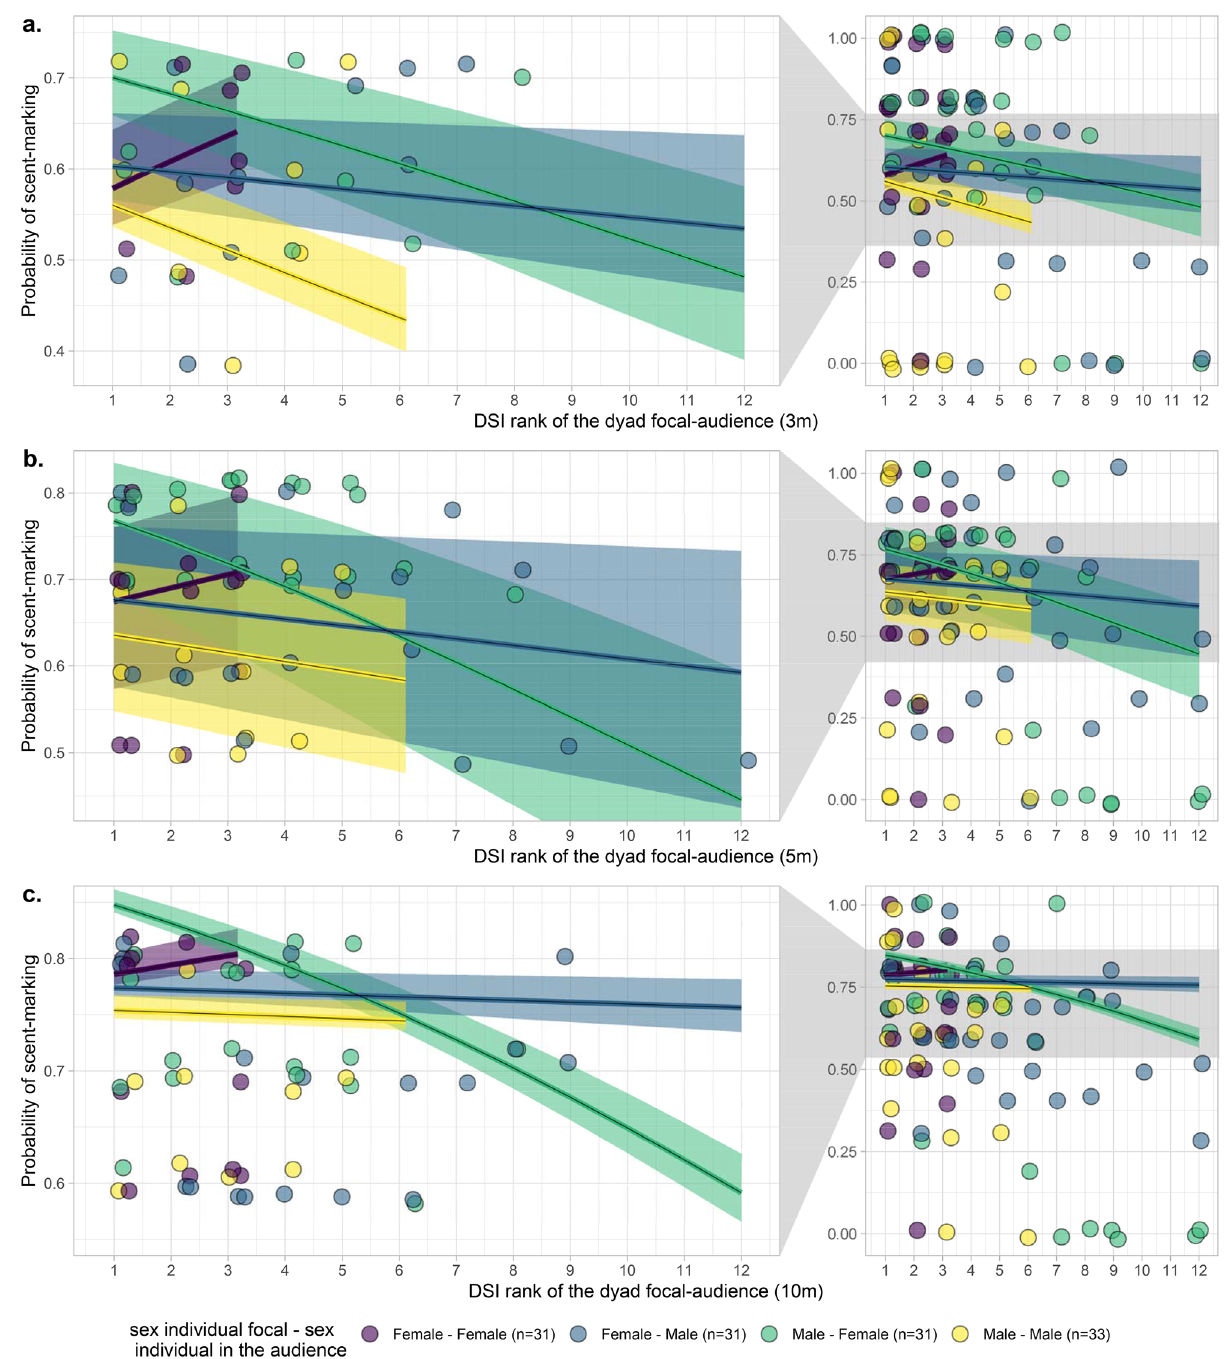
Figure 2. Probability to scent-mark as a function of the DSI rank of the dyad for an audience ( a ) in a 3 m radius,( b ) in a 5 m radius, and ( c ) in a 10 m radius. The shaded areas show 95% confidence intervals of the model (conditional on the number of observations being at its average and on a group effect weighted by the number of individuals in each group). The first column of plots presents the zoomed-in section of the full range, indicated by grey polygons, to better depict the corresponding regression lines. This figure was visualized and edited using R (https:// www.r- proje ct. lemurs, as suggested in an earlier study 65 , males might use anogenital scent marking as a way to advertise their social status to other males and as an indirect form of competition. This function of scent marking has also been suggested for several other lemur species (e.g. ring-tailed lemurs 8,72 , Verreaux’s sifaka 38,73–75 ; red lemurs Eulemur rufus 46 ; Milne-Edward’s sifakas Propithecus edwardsi 76,77 ; silky sifakas P. candidus 76 ; grey mouse lemurs Micro- cebus murinus 78 ) and other mammalian species 45 (e.g. brown bears, Ursus arctos 79 , house mice Mus musculus 80 ).